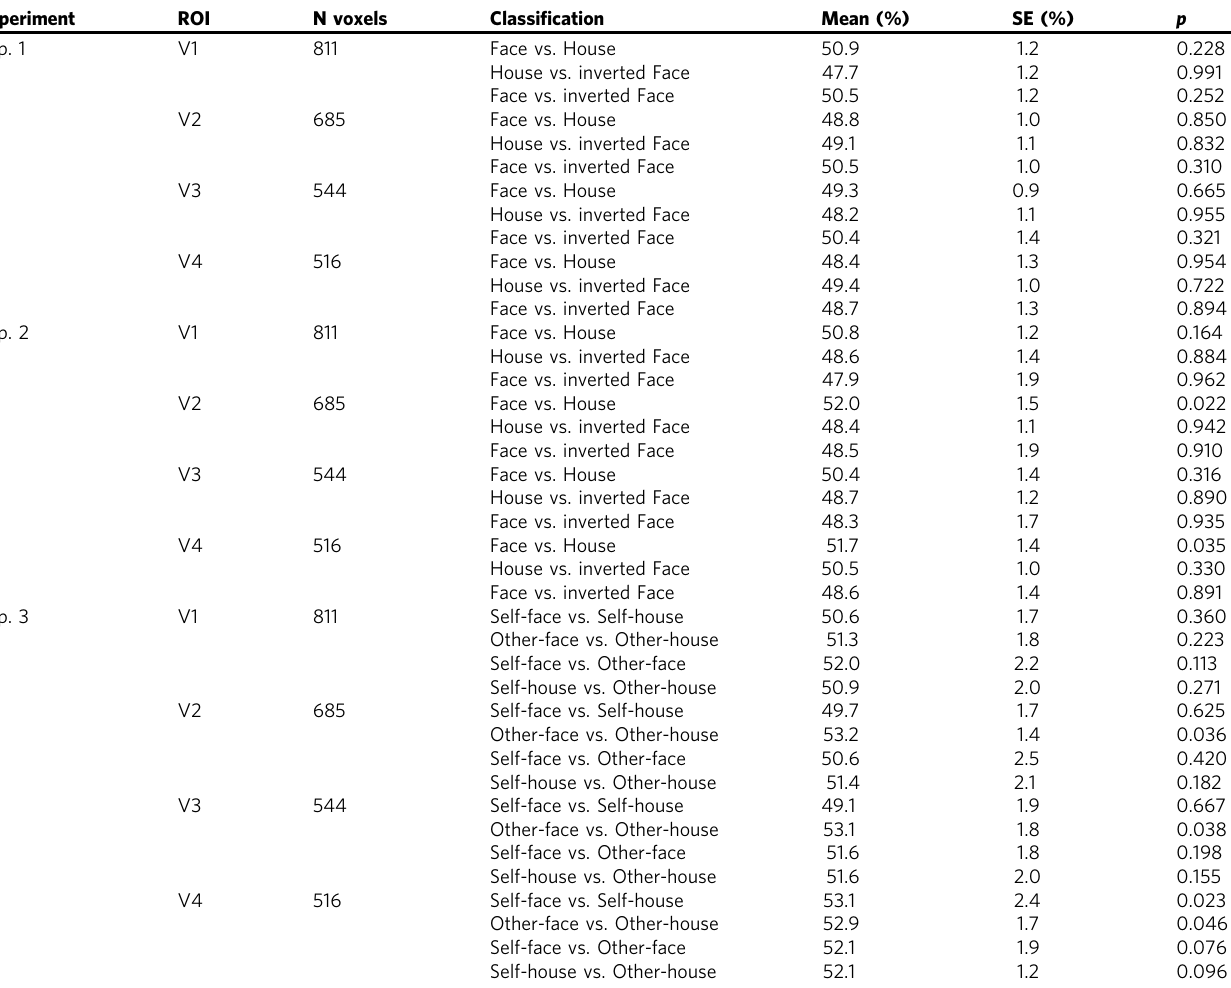
Table 3 Multivariate decoding results of early visual areas. Experiment ROI N